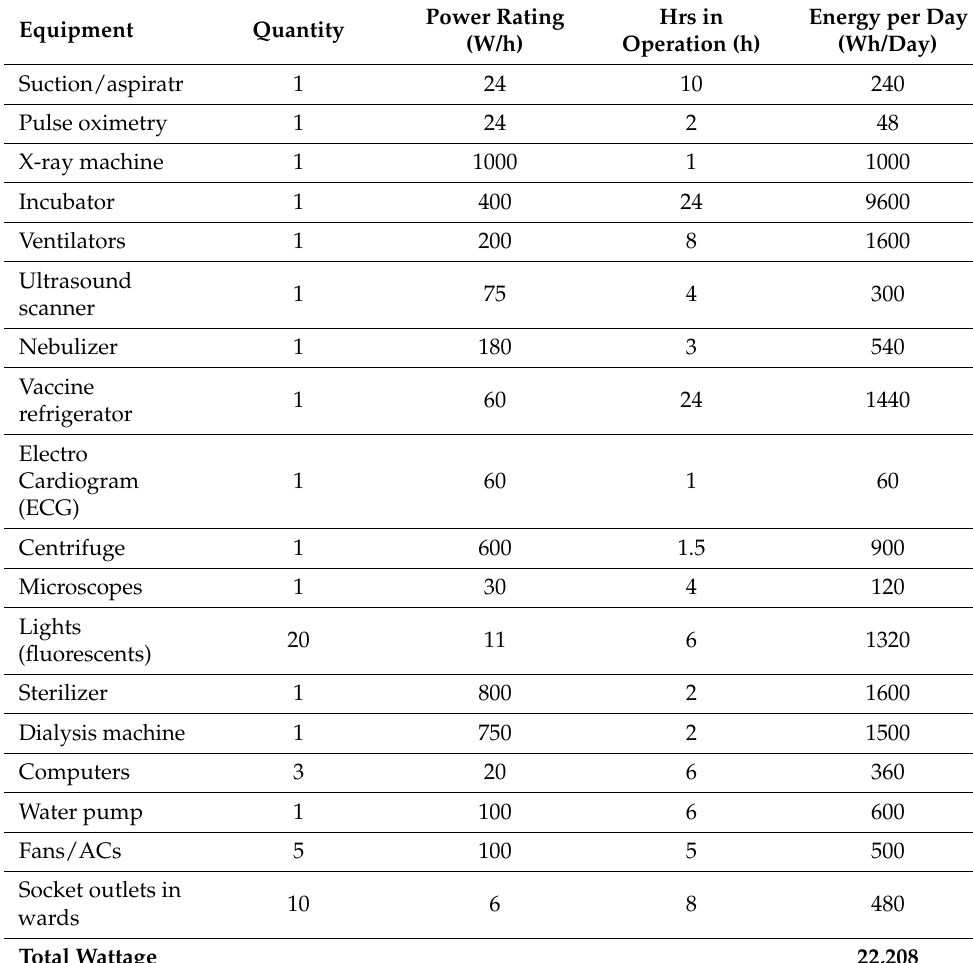
Table 2. Load profile of rural healthcare facilities.